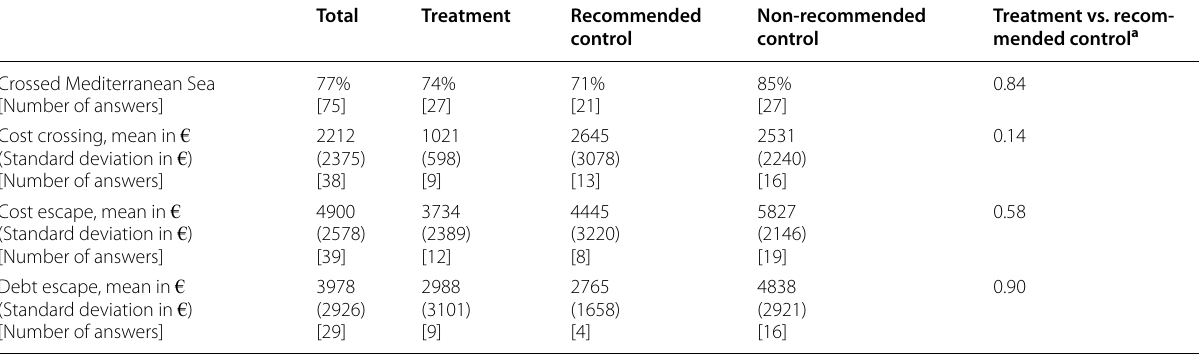
Source ZEW inclusive soccer project survey; own calculations a